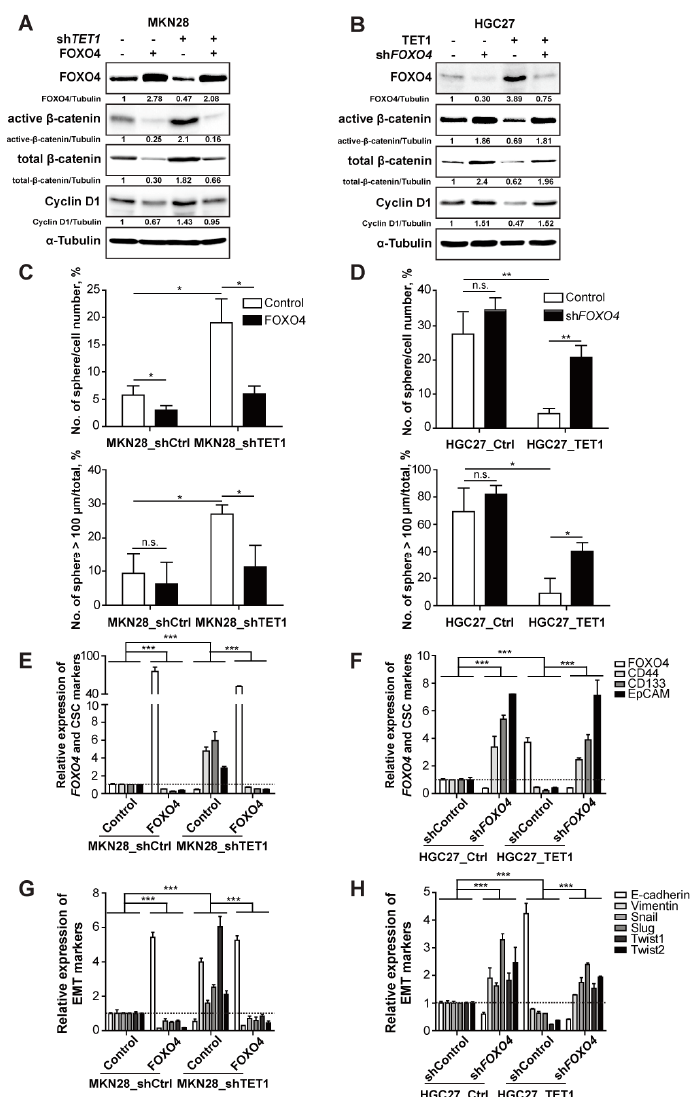
Figure 6. TET1 inhibits Wnt signaling through FOXO4 transactivation. ( A ) Immunoblot analysis of indicated proteins in MKN28 stable cell lines. ( B ) Immunoblot analysis of indicated proteins in HGC27 stable cell lines. ( C , D ) Numbers of spheres per 100 cells ( upper ) and percentage of spheres with diameter >100 µm ( lower ) of indicated MKN28 cells ( C ) and HGC27 cells ( D ). ( E , F ) qRT-PCR analysis of FOXO4 and cancer stem cell markers in MKN28 cells as in ( A , E ) and in HGC27 cells as in ( B , F ). ( G , H ) qRT-PCR analysis of the EMT markers in MKN28 cells as in ( A , G ) and in HGC27 cells as in ( B , H ). Error bars indicate mean ± SD. ***, p < 0.001. **, p < 0.01. *, p < 0.05. n.s., not signifi- cant.